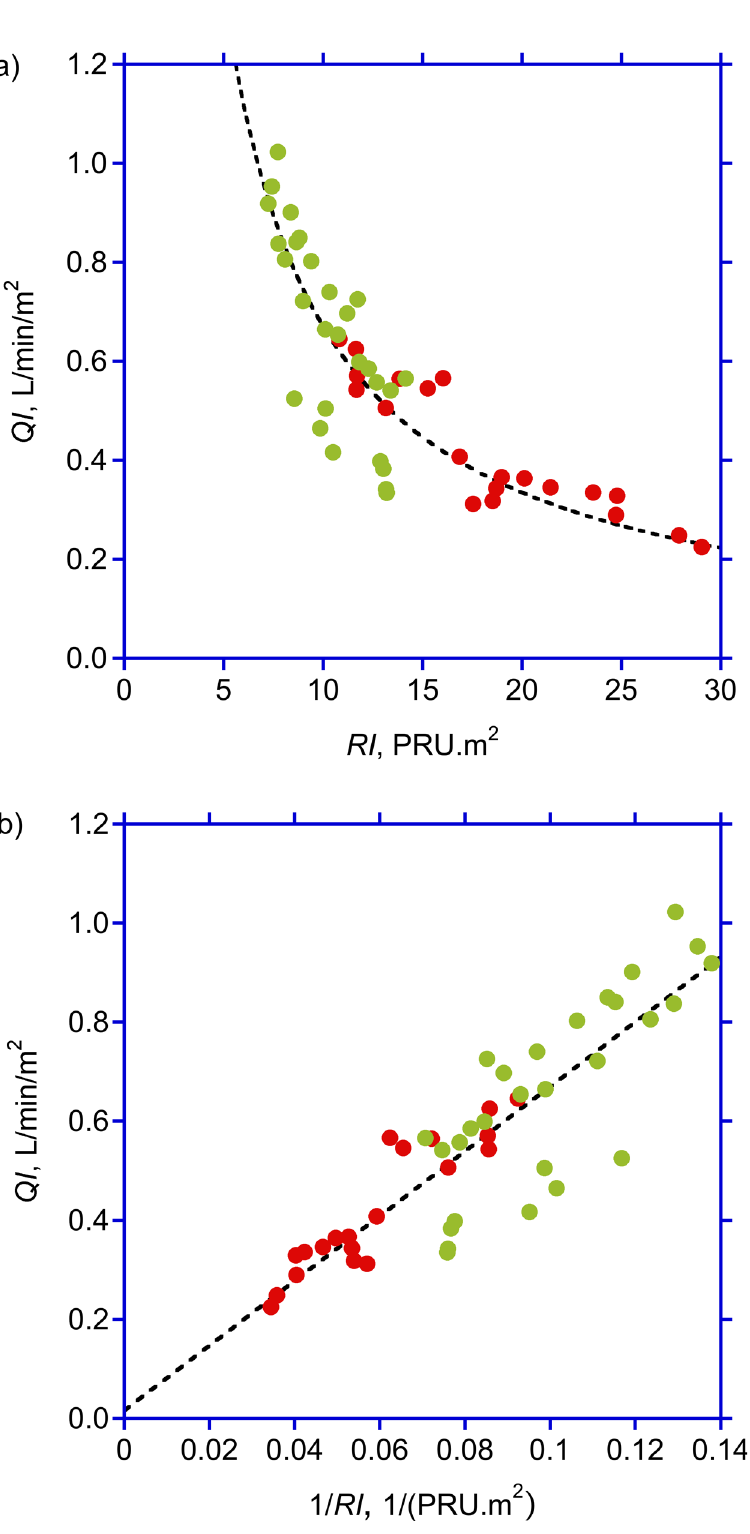
Fig 1. Hepato-splanchnic perfusion and resistance. Splanchnic perfusion index ( QI ) as function of hepato-splanchnic resistance index ( RI ) (top panel) and hepato-splachnic vascular conductance (bottom panel), respectively, during hemodialysis, in diabetic (red symbols) and non-diabetic (green symbols) subjects. Broken lines indicate the best fit of QI to RI (top panel, y = 6.71/ x , r 2 = 0.77) and 1/ RI (bottom panel, y = 0.02+6.54 x , r 2 = 0.77), respectively.